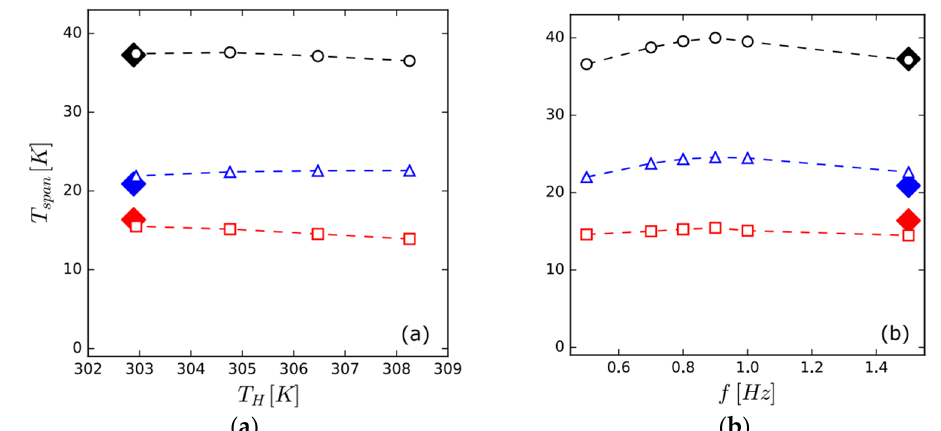
Figure 25. Results comparison of the optimal operating point to have the best temperature range between the semi-analytical model (diamonds points) and the experimental measurements (dashed lines) versus ( a ) the hot side temperature and ( b ) frequency. The red squares represented are relative to the hot layer, blue triangles to the cold layer, and black circles to the total temperature range [109].